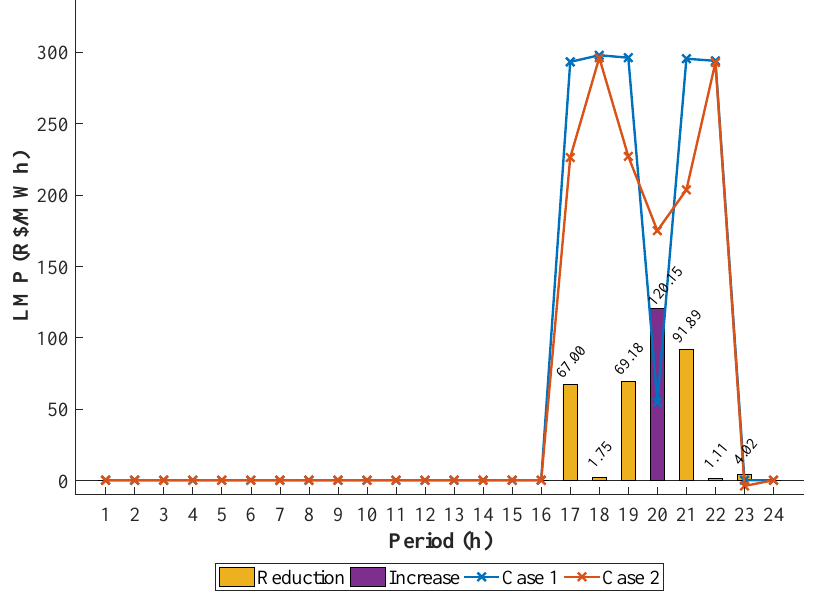
Figure 15. LMP in Case 1 and Case 2 at bus